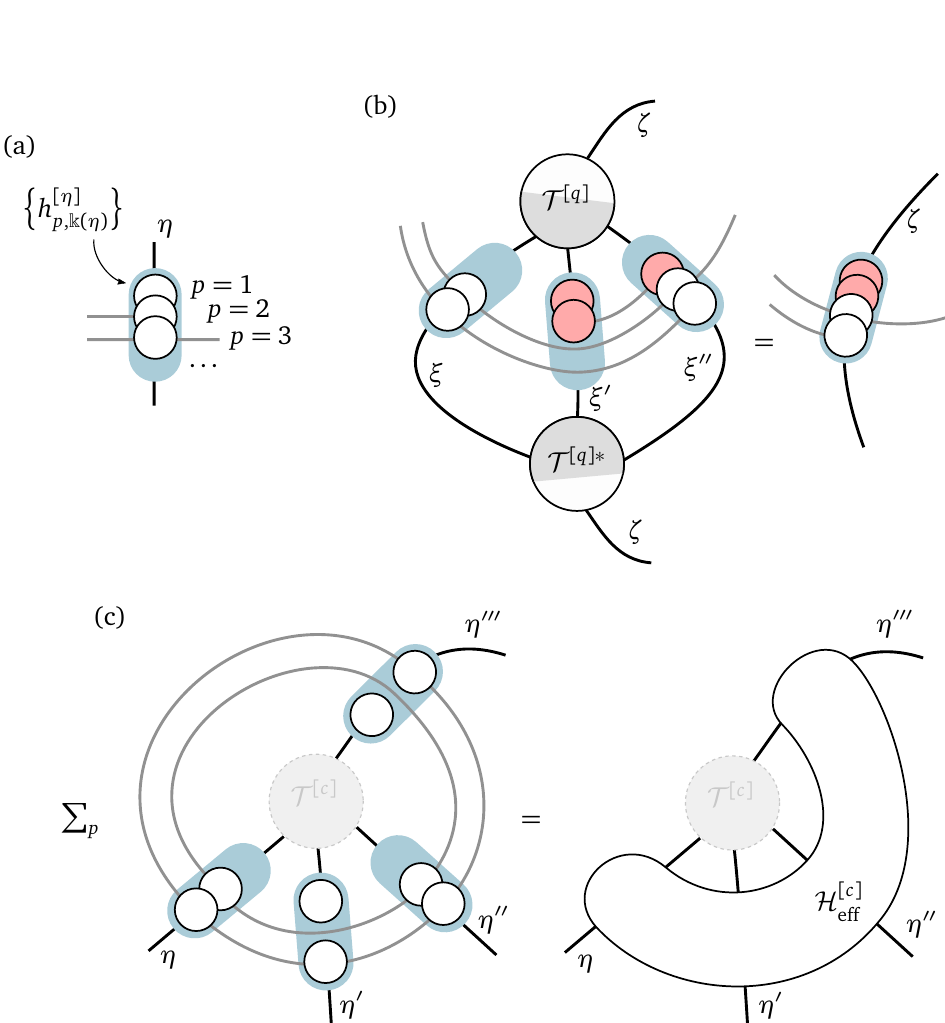
Figure 37: Building blocks of the GS algorithm: (a) Local interaction operators are defined on the (physical and virtual) network links. Tensors inside the blue shaded [ η ] area on a link η represent local operations h , each with a different p . Not for p , k ( η ) every p in the Hamiltonian’s sum Eq. (67) there must be a tensor defined at every link η ; the missing ones are implicitly treated as identities. (b) Renormalizing the local interactions from the links ξ , ξ (cid:48) , ξ (cid:48)(cid:48) towards the virtual link ζ . Each interaction p is contracted independently into a renormalized term, and the global sum over p is not carried out explicitly. An exception are renormalized operators p that have no TPO links left (for example the two independent interactions indicated in red), which can already be summed into a single new renormalized tensor. (c) The effective Hamiltonian involves the contraction of all renormalized Hamiltonian terms over all tensor links { η } at the center node c . Often, the final sum over p is postponed, c [ c ] e.g. until contracting the individual terms h into the tensor T [ c ] as described in p ,eff Sec. 5.1.3 (solving the reduced optimization problem). The figure also shows the center tensor (semi-transparent) to highlight how it is acted upon by the effective Hamiltonian, which is a key ingredient for the GS